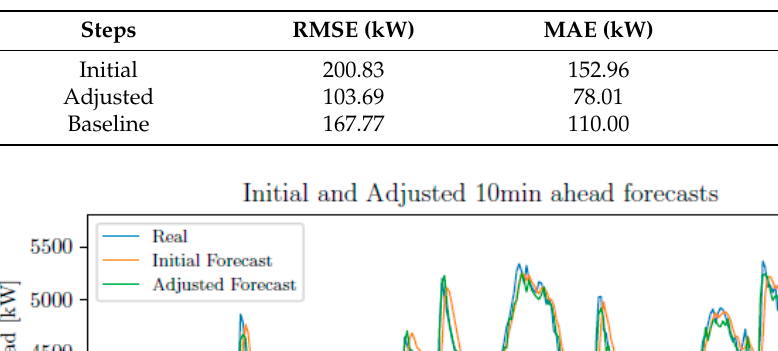
Table 10. Summary of the adjusted models for the three horizons.